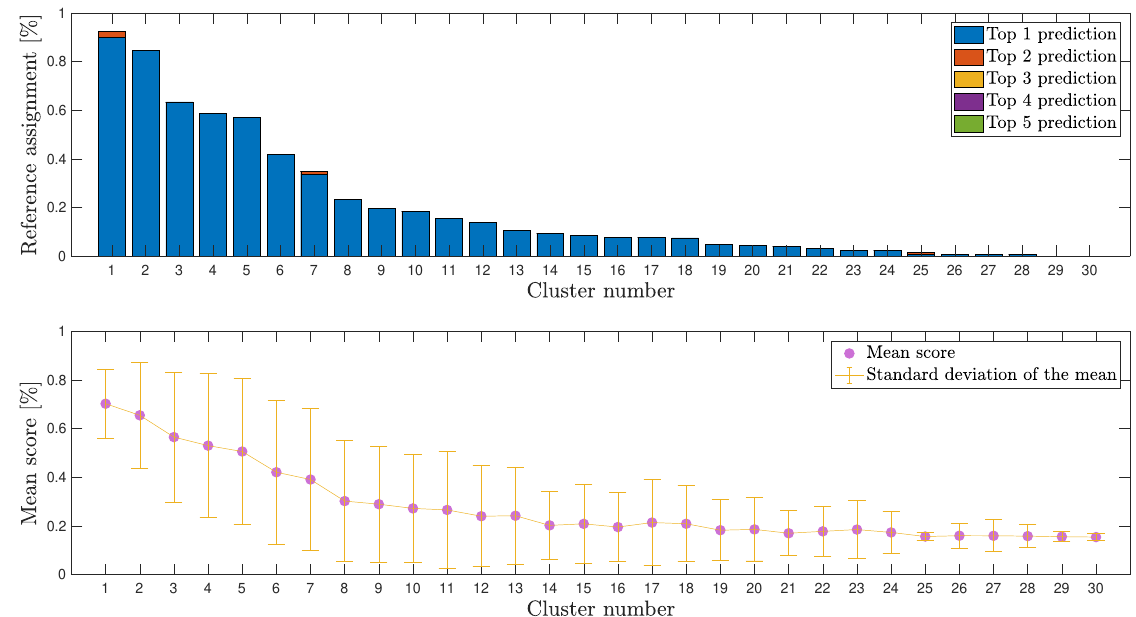
Figure 8. The figure on the top shows the proportion of correct class assignments within a cluster using the five highest scored classes, where the clusters are in descending order of that proportion. In the bottom figure the mean score as well as the standard deviation of the scores for the images of cluster k are plotted, where the clusters are in the same order as